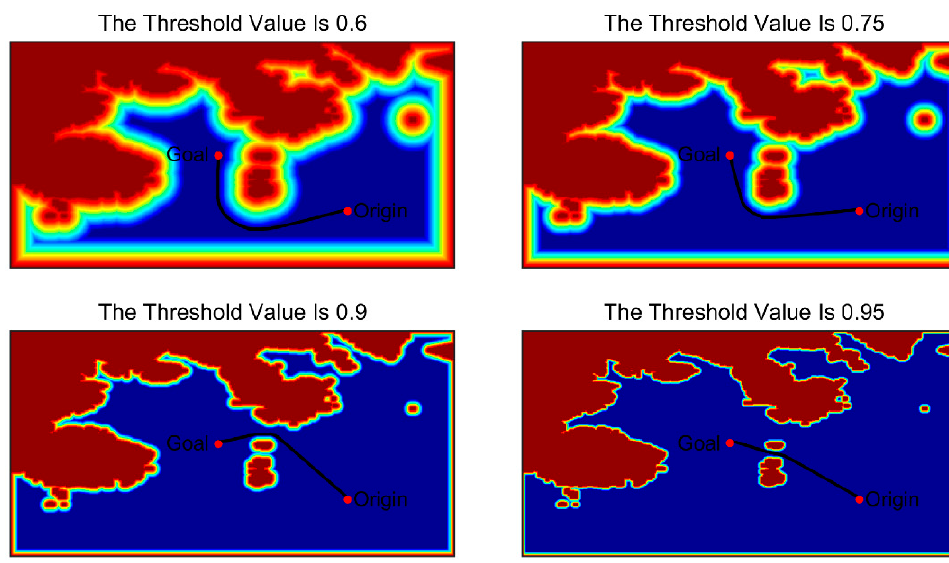
Figure 10. Generated paths in environments with di ff erent threshold Figure 10. Environment model after different threshold processing.